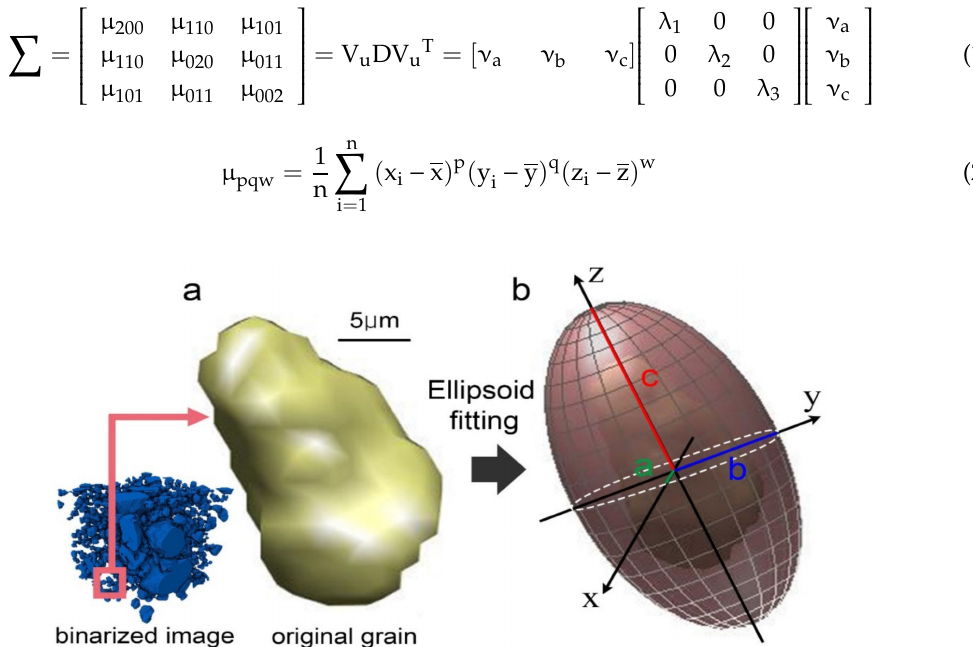
Figure 5. Diagram of ellipsoid fitting process. ( a ) All grains in the MATLAB calculation were recognized as individual objects, maintaining their size and shape. ( b ) After the fitting is automatically applied, each grain is converted into an ellipsoid, from which the length and the direction can be obtained by measuring the length (a, b, c) of principle axes (x, y, z) and the orientation of the longest axis ( z -axis). x, y, and z are the axes of ellipsoid with vector components, and a, b, and c are the lengths of each axis. V µ is the unit vector of the principal axes, λ 1 , λ 2 , and λ 3 are moments of inertia along the